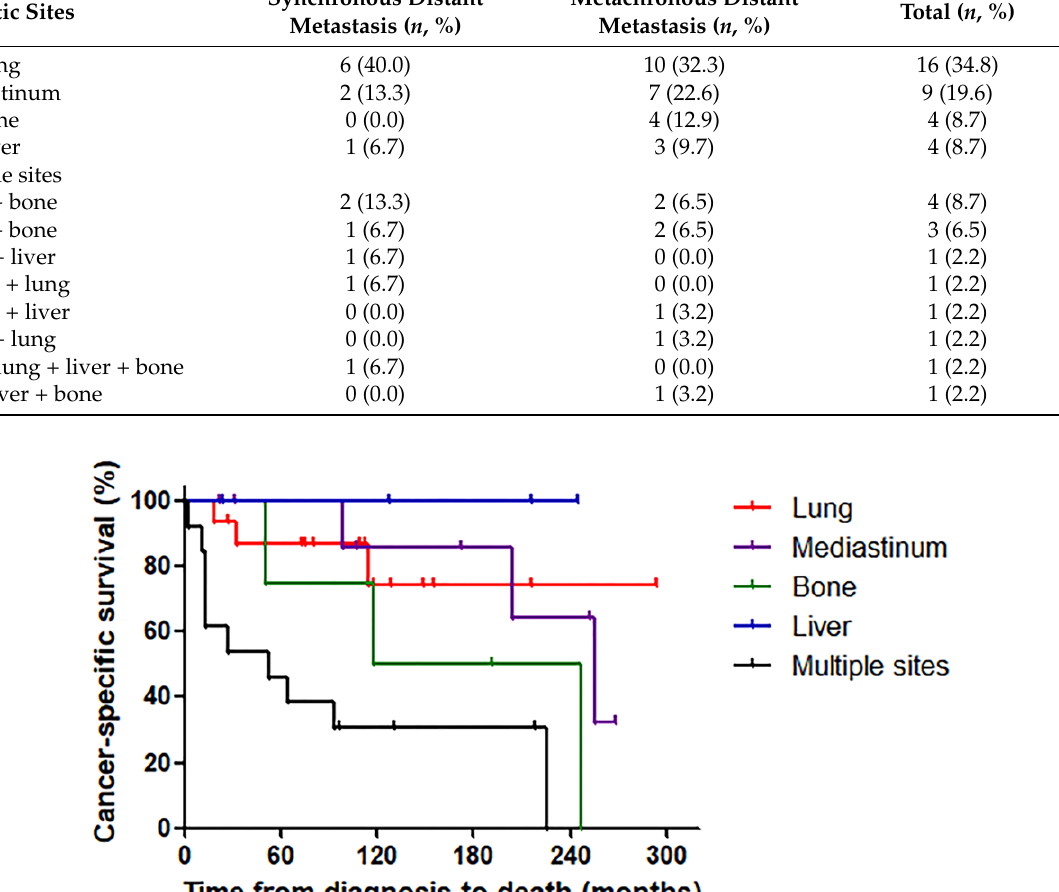
6.11; p = 0.006) than for lung metastasis (Table 4). In fact, four of the 19 patients died